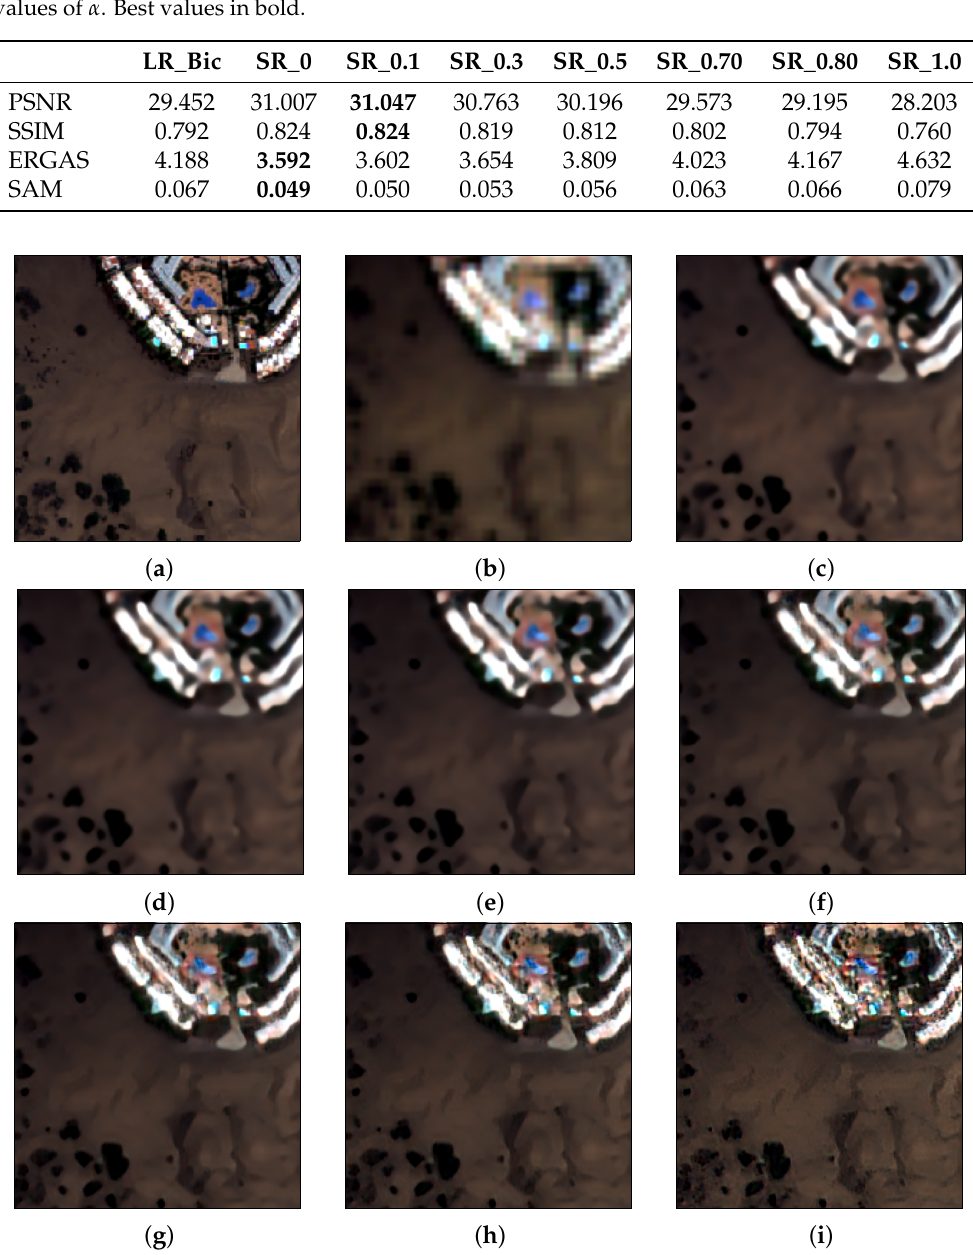
Figure 10. Results of a region of Maspalomas-2017 from the Test Set. ( a ) WorldView-2 GT, ( b ) Sentinel- 2 bicubic interpolation, ( c ) SR with α = 0, ( d ) SR with α = 0.1, ( e ) SR with α = 0.3, ( f ) SR with α = 0.5, ( g ) SR with α = 0.7, ( h ) SR with α = 0.8, ( i ) SR with α = 1. Image size: 200 × 200